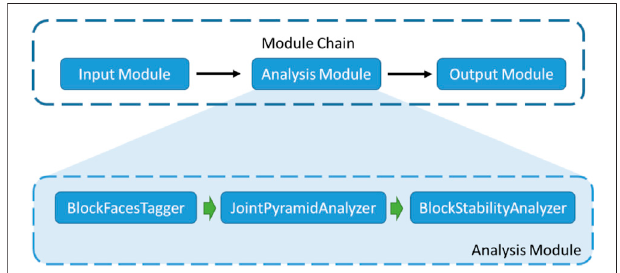
FIGURE 3 | Design of block stability analysis